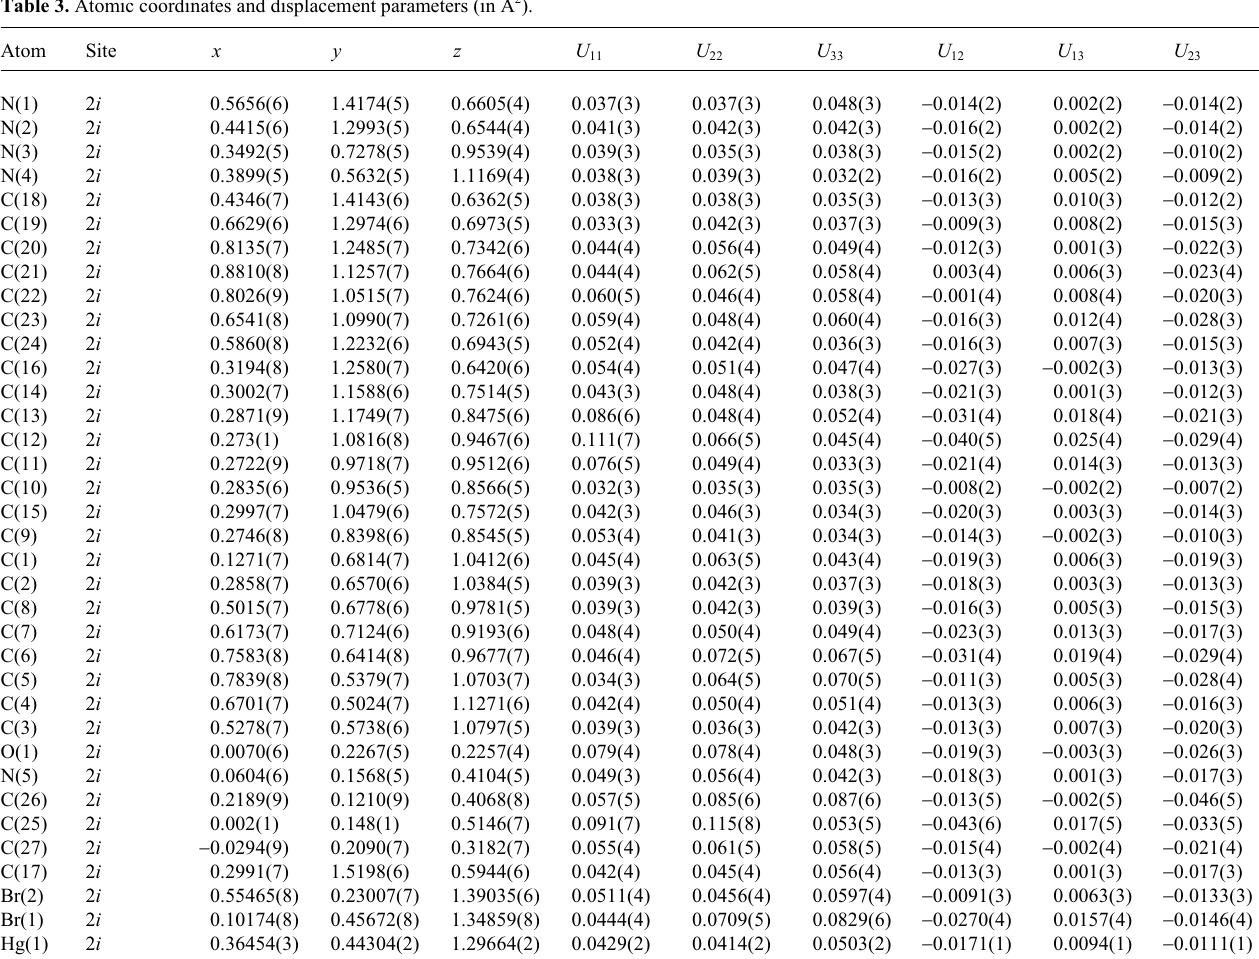
Table 3. Atomic coordinates and displacement parameters (in Å 2 ).